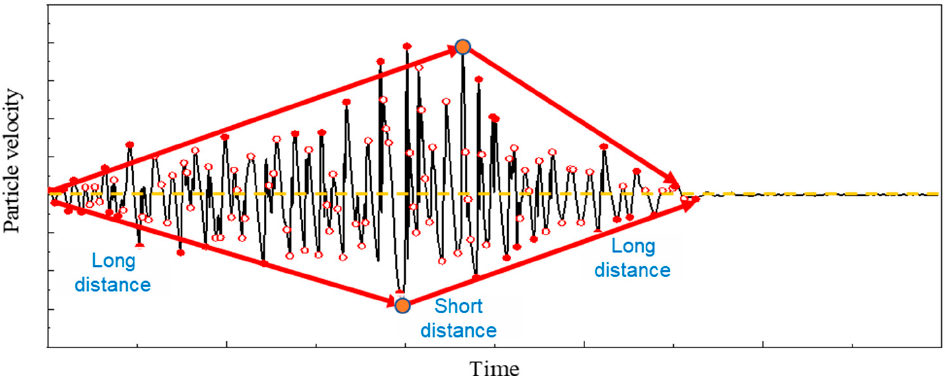
Figure 2. Vibration signal of open-pit deep-hole blasting.